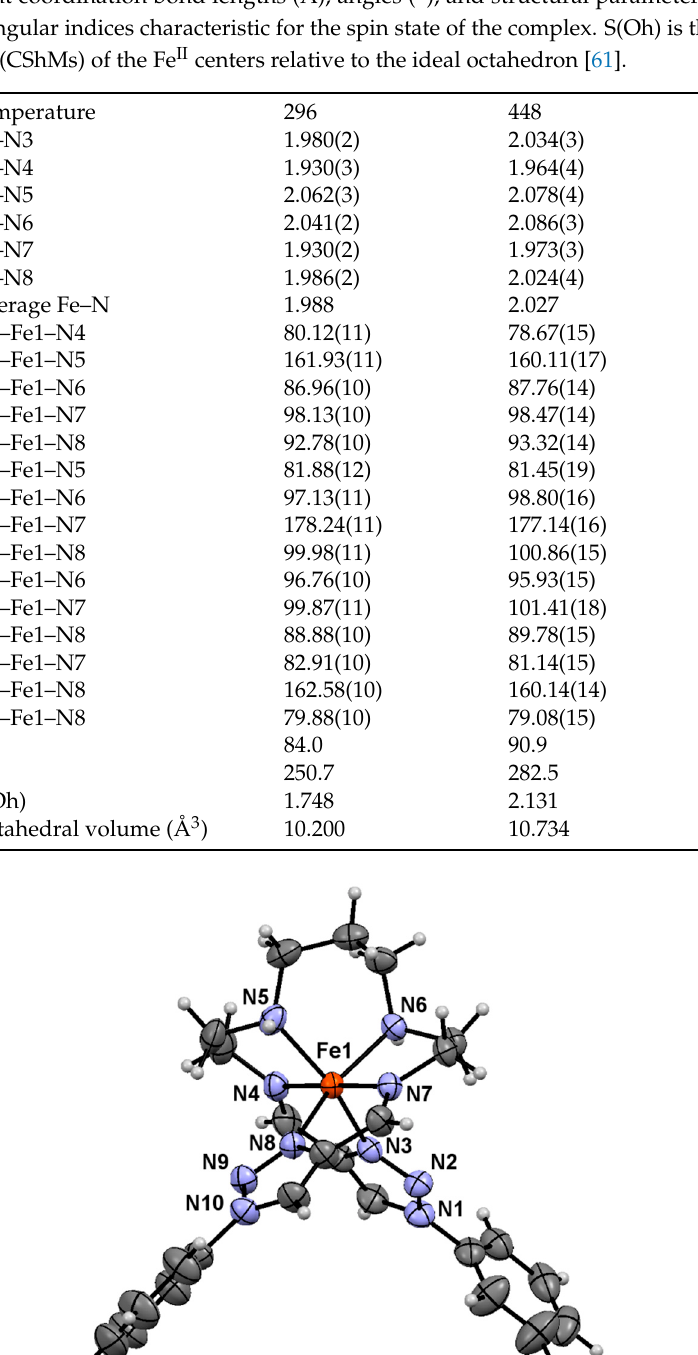
Figure 6. Molecular arrangement of 1 at 296 K, projected on the ( a ) ab -plane and ( b ) bc -plane. Adjacent complex cations [Fe(L 2-3-2Ph )] 2+ are connected by intermolecular CH ⋯ π (green dotted line) and π – π (black dotted line) interactions, forming the 3D network. Cg1 = centroid of the C1–C6 ring (transparent red) and Cg2 = centroid of the C20–C25 ring (transparent blue). Symmetry operations: (i) − x, y, 3/2 − z, (ii) x, − 1 + y, z, (iii) − x, − 1 + y, 3/2 – z, (iv), – x, 1 – y, – z. H atoms and AsF 6 − ions have been omitted for clarity. 3. Materials and Methods 3.1. Synthesis of the Fe II Complex 3.1.1. General All reagents and solvents were purchased from commercial sources and used for the syntheses without further purification. The compound 1-phenyl-1 H -1,2,3-triazole-4-carbaldehyde was prepared according to methods in the literature [36,63–65]. Complexation and crystallization of 1 were performed under nitrogen atmosphere using standard Schlenk techniques. Other synthetic procedures were carried out in air. 3.1.2. Synthesis of the Linear Hexadentate N 6 Ligand L 2-3-2Ph = bis[ N -(1-Phenyl-1 H -1,2,3-triazol-4- yl)methylidene-2-aminoethyl]-1,3-propanediamine)